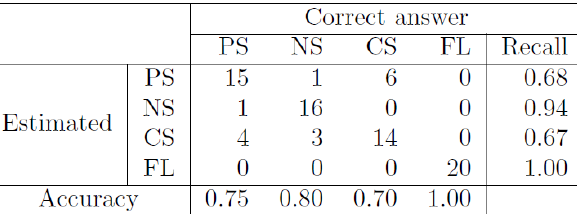
Table 2: The results of the classifying experiment